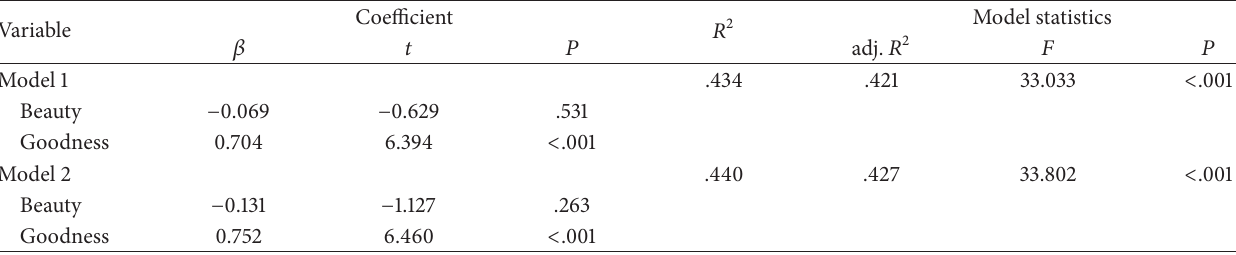
Table 2: Results for the mediation model specified in H3.1. The model was tested with regression analysis predicting perceived usability (PQ- scale AttrakDiff2 questionnaire) on the basis of perceived beauty and perceived goodness. Perceived beauty was measured with a 7-point rating scale (Model 1) and by a single-item of the APPEAL scale of the AttrakDiff2 questionnaire (Model